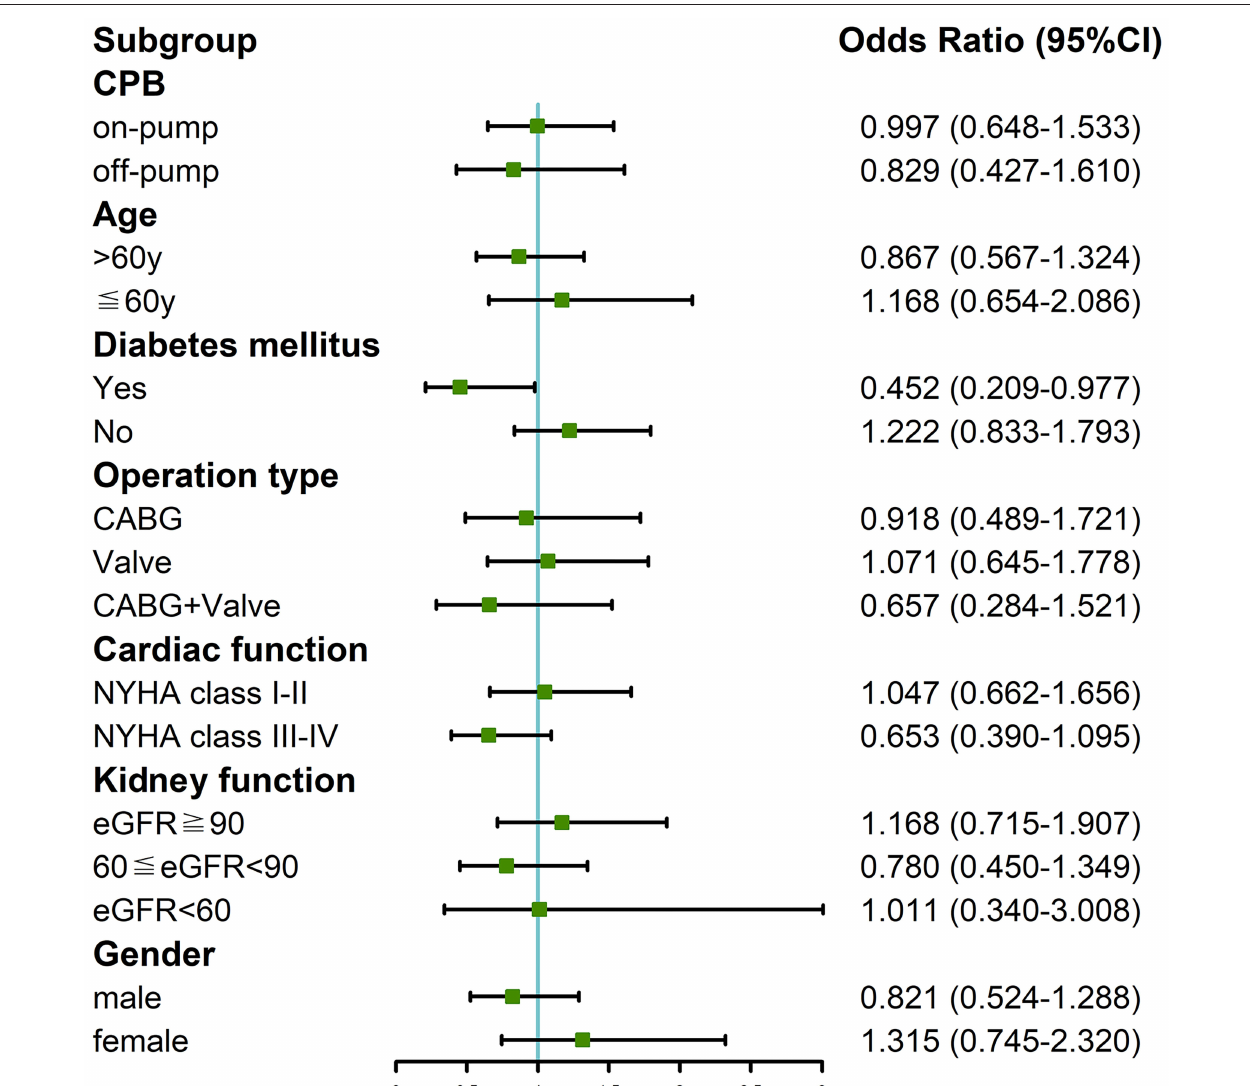
FIGURE 1 | Subgroup analysis of the association between 7-day interval from CAG to cardiac surgery and incidence of CSA-AKI in our cohort